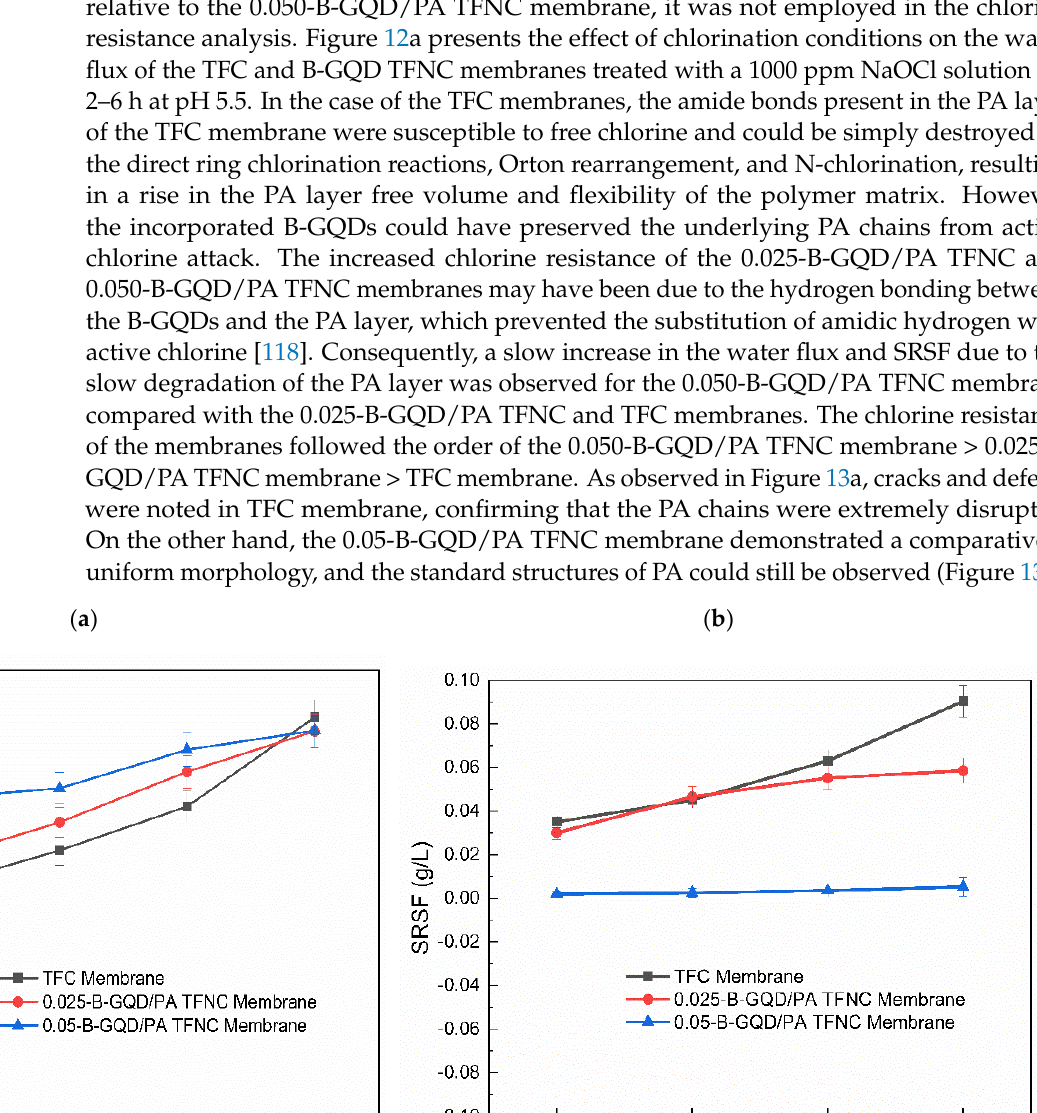
Figure 13. ( a ) SEM image of the TFC membrane treated with a 1000 ppm NaOCl solution for 2 – 6 h at pH 5.5; ( b ) SEM image of the 0.050-B-GQD/PA TFNC membrane treated with a 1000 ppm NaOCl solution for 2 – 6 h at pH 5.5. Figure 12b presents the SRSF of the TFC and B-GQD TFNC membranes treated with a 1000 ppm NaOCl solution for 2 – 6 h at pH 5.5. It was observed that the SRSF values of the TFC and TFNC membranes treated with an acidic NaOCl solution (pH = 5.5) gradually increased over chlorination time. The surging rise of SRSF was avoided due to the com- pact and dense PA layer structure [118]. The SRSF of the membranes under chlorination exposure followed the order of the TFC membrane > 0.025-B-GQD/PA TFNC membrane > 0.050-B-GQD/PA TFNC membrane. The rate of increase in SRSF values were maximum